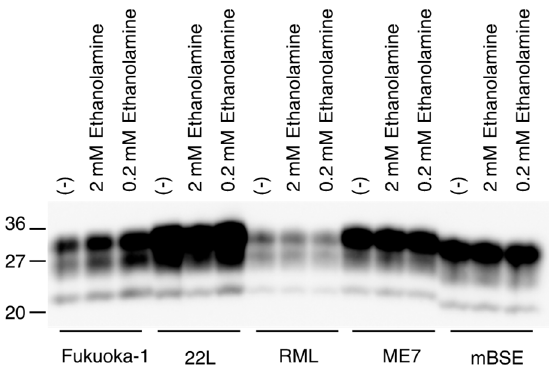
Figure 6. Ethanolamine does not disturb in vitro conversion of PrP C into PrP Sc . Western blotting of PMCA products performed with or without ethanolamine after treatment with PK.